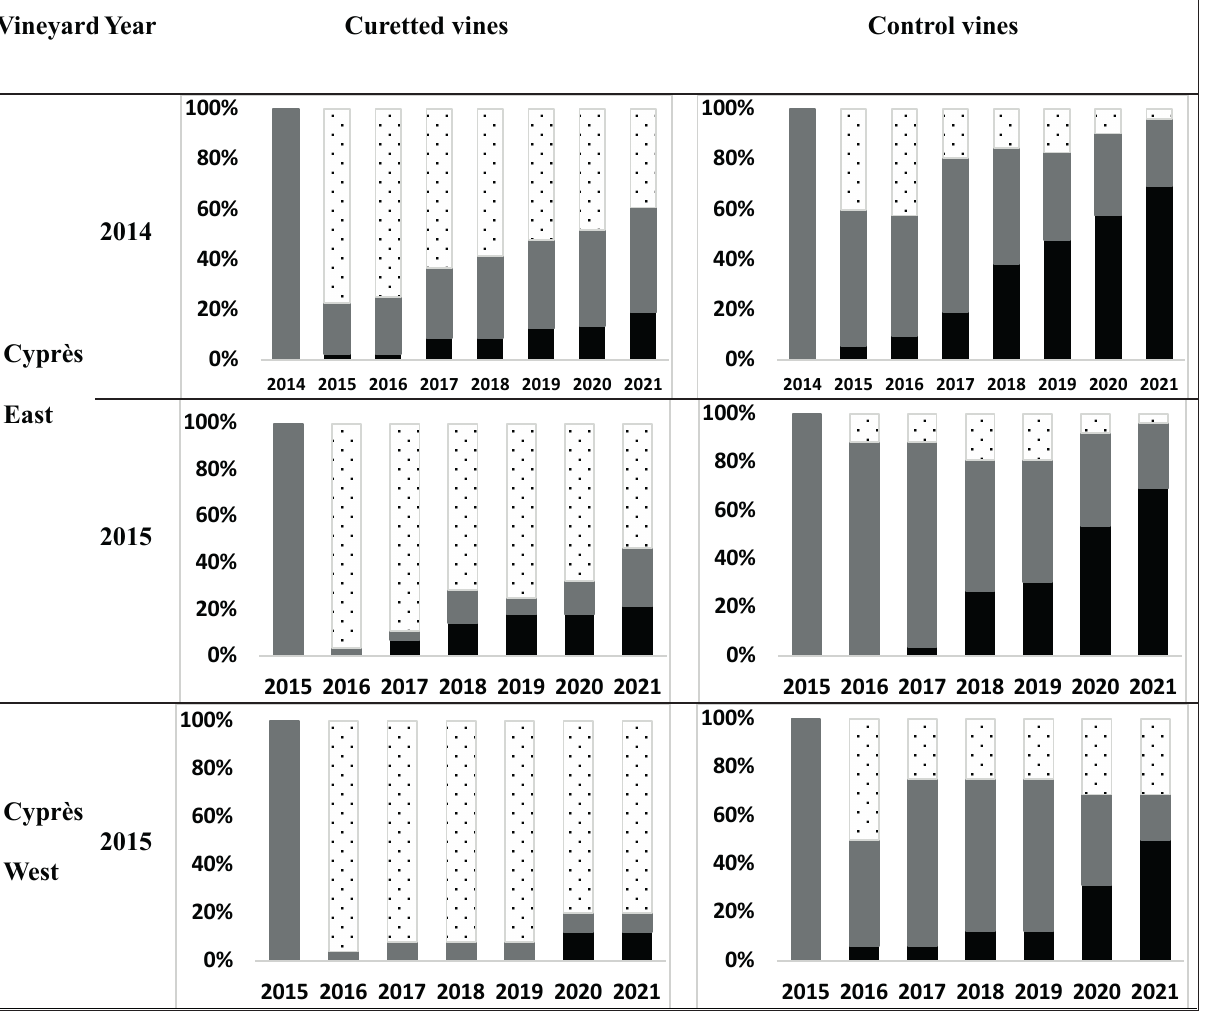
Figure 4. Percent of curetted and control vines, by year, for up to 6 and 7 years after the curettage treatment. The vines concerned were those curetted in 2014 and 2015 at Cyprès East (Exp. 1) and Cyprès West (Exp. 2). The X-axis relates to the rating years and the Y-axis relates to the % in each symptom category: asymptomatic vines are shown in white with black dots, esca-symptomatic are shown in dark gray and dead vines are shown in